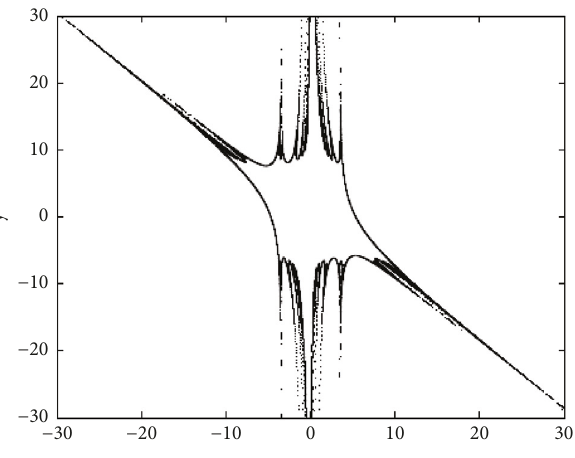
Figure 1: Original Julia sets of system (5) when 𝜂 = 0.08, 𝑏 = 0.02, 𝑐 = 0.005, 𝑞 = 0.005, 𝑒 = 0.05, 𝑧 = 0.005, 𝛿 = 0.001